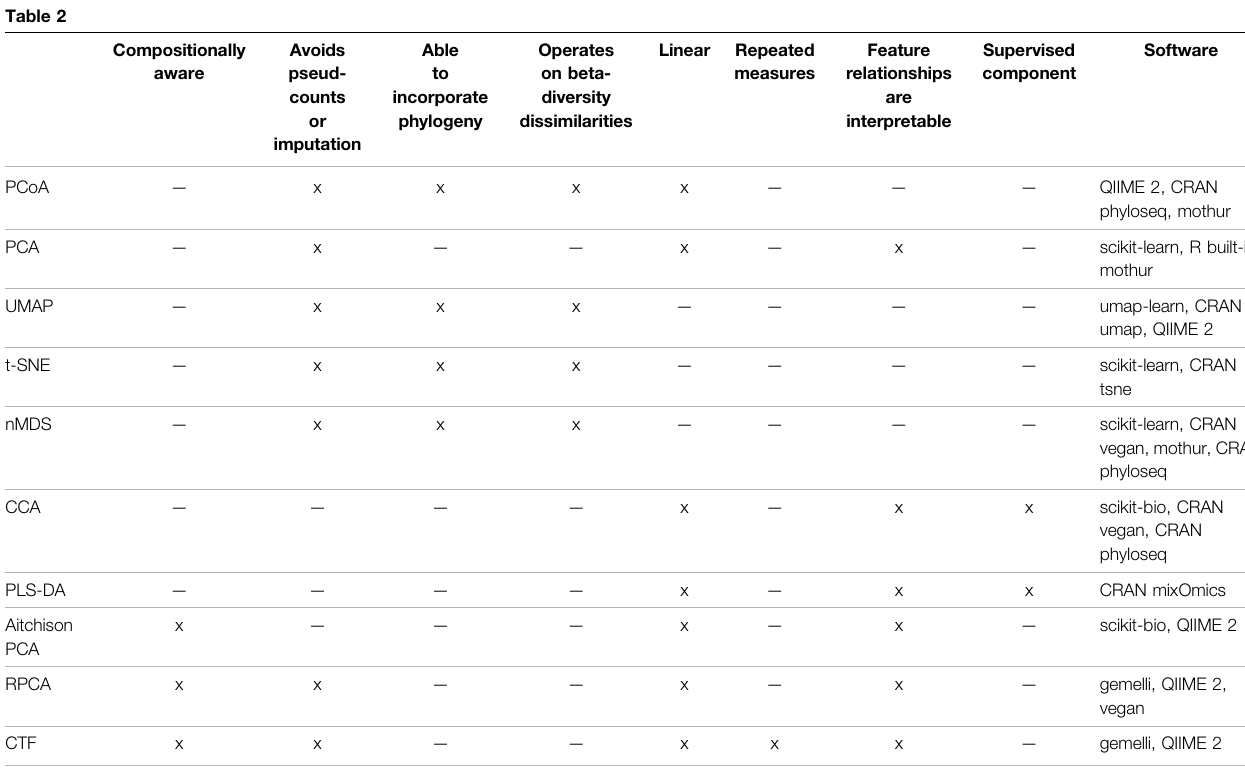
TABLE 2| Dimensionalityreduction methods each have their own characteristics. xindicates that thecharacteristic applies to the method. Examples ofsoftware capable of performing each method are included in the last column. Table 2 Compositionally